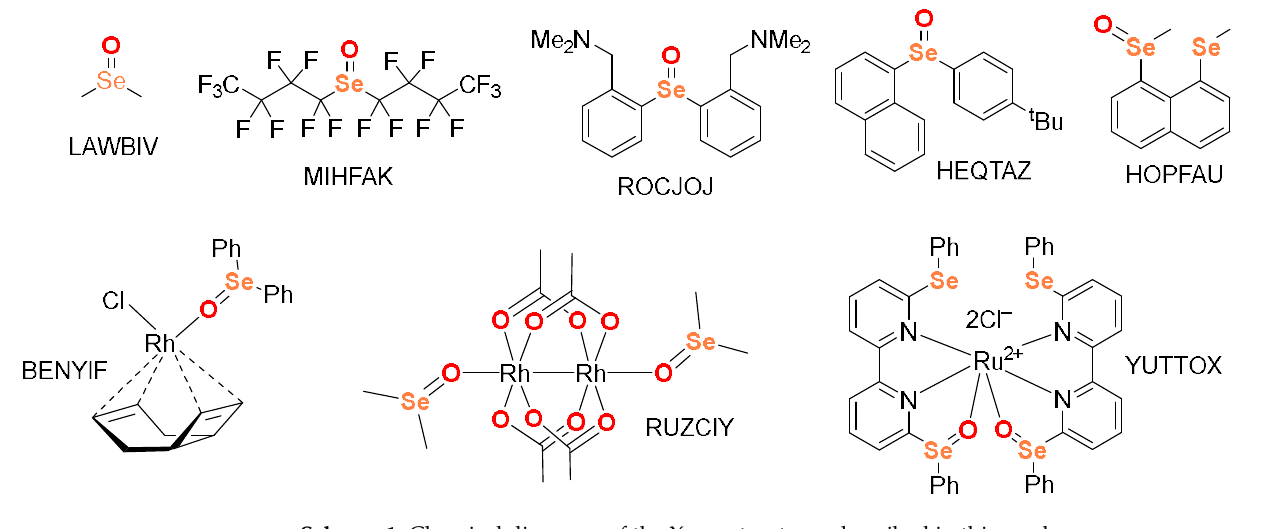
Scheme 1. Chemical diagrams of the X-ray structures described in this work.